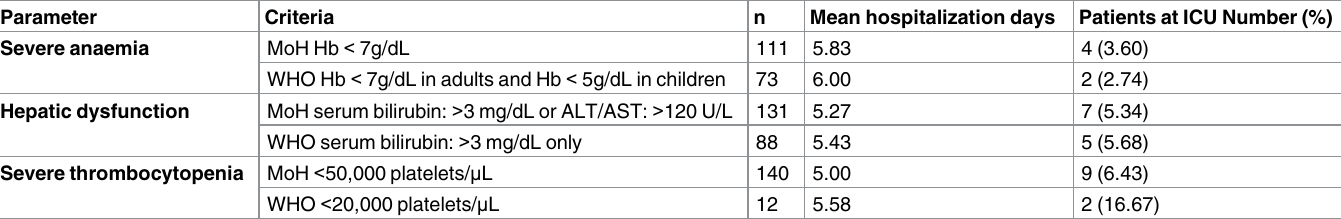
Table 2. Mean hospitalizations days and number of patients at the ICU.